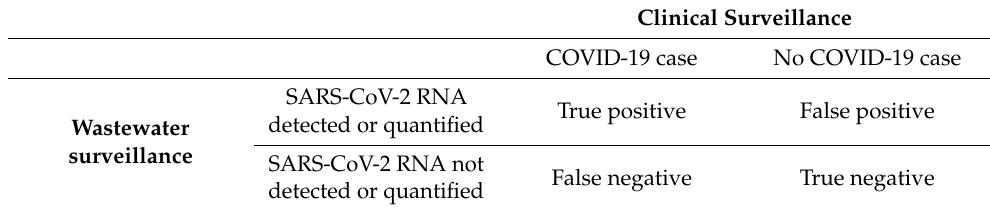
Table 2. Classification of wastewater surveillance and clinical detection of COVID-19